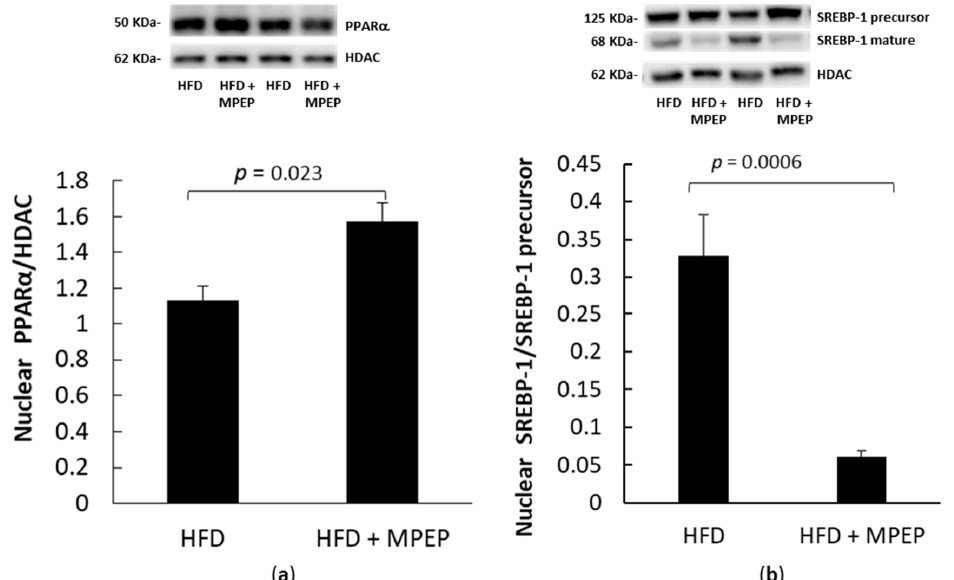
Figure 4. PPAR α and SREBP-1 in obese mice. ( a ) PPAR α in liver nuclear extracts from obese mice after 7 weeks of HFD administration, treated with MPEP 20 mg/Kg or vehicle; ( b ) mature SREBP- 1/SREBP-1 precursor ratio in nuclear extracts from obese mice after 7 weeks of HFD administration, treated with MPEP 20 mg/Kg or vehicle. HFD: high-fat diet + vehicle group; HFD + MPEP: high-fat diet + 20 mg/Kg MPEP group. Results are mean ± SE of 6 individual